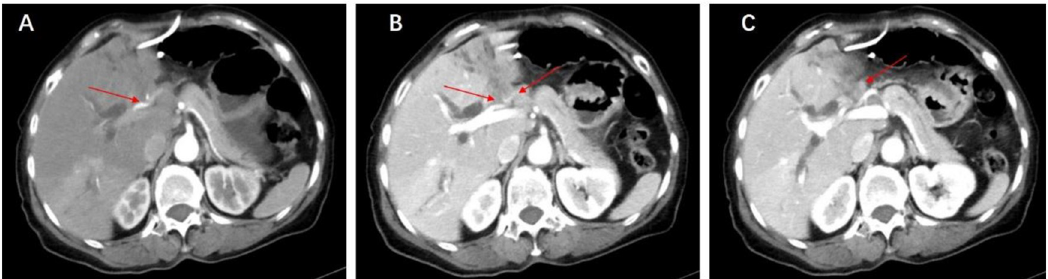
Fig 2. Illustration of hepatic artery, portal vein invasion and lymph node metastasis. A. Invasion of right hepatic artery (red arrow). B. Invasion of left portal vein and left hepatic artery (red arrow). C. Lymph node metastasis (red